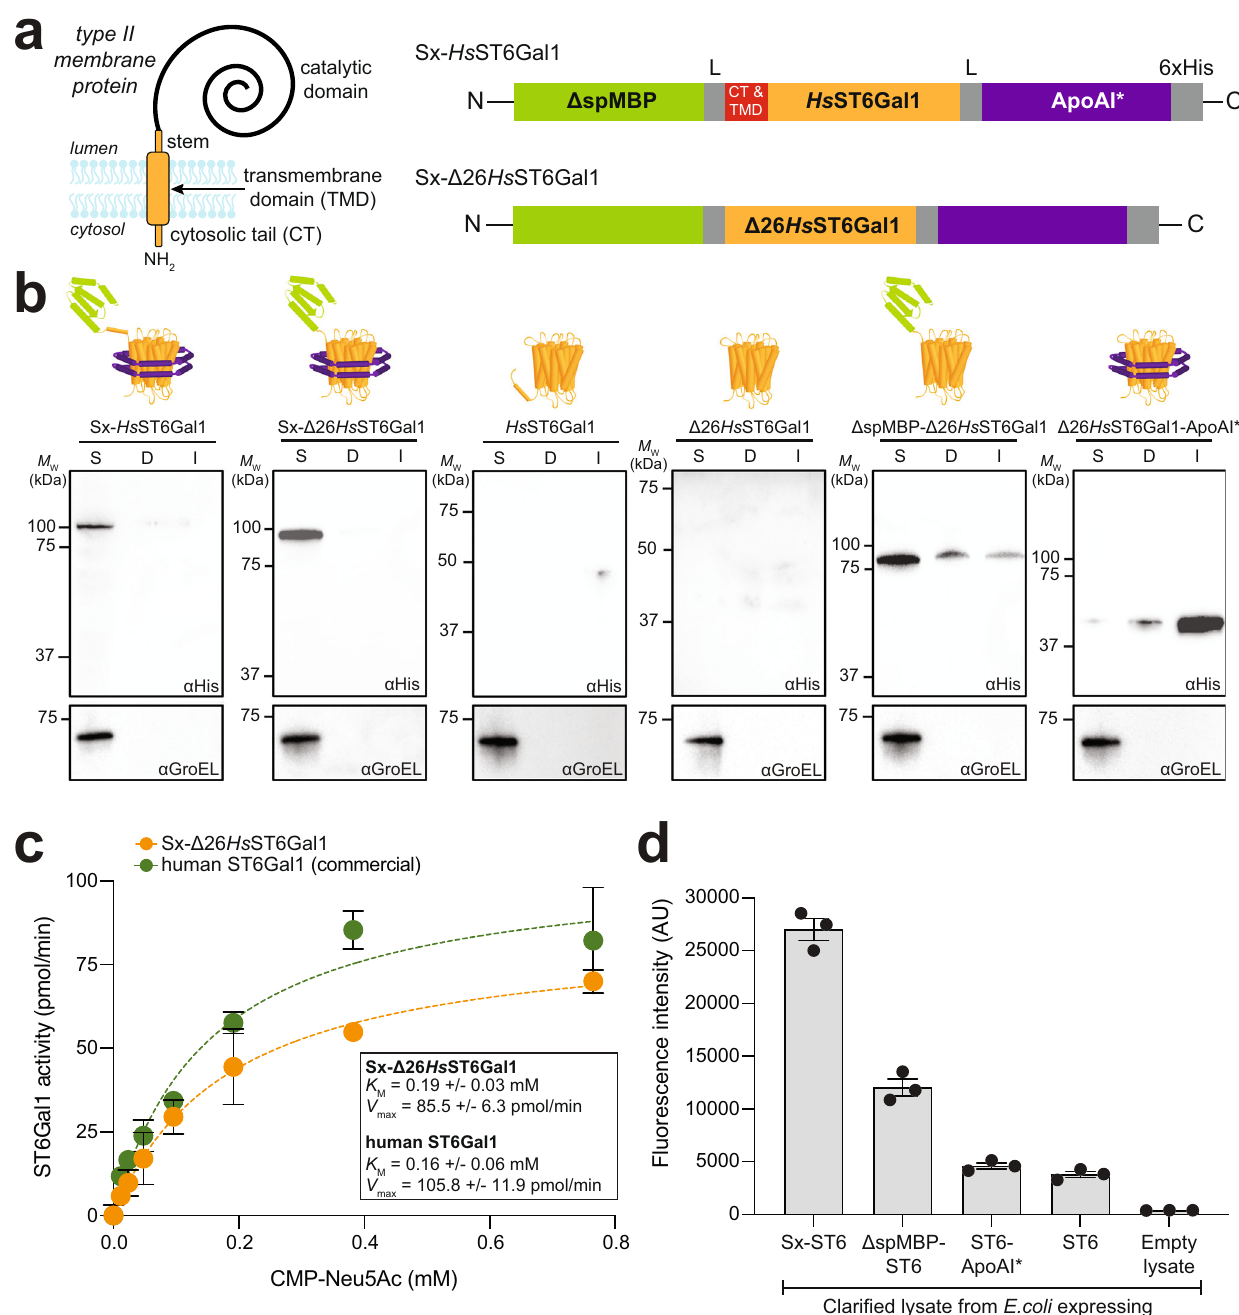
Fig. 1 | SIMPLEx-mediated expression of biologically active Hs ST6Gal1. a Membrane topology of type II transmembrane proteins and molecular archi- tecture of SIMPLEx constructs used in this study. Each construct consisted of N-terminal Δ spMBP and C-terminal ApoAI* that fl anked Hs ST6Gal1. Intervening fl exible linker (L) connects Δ spMBP and ApoAI* to the GT domains while the 6xHis tag was placed at the C-terminus to facilitate detection and puri fi cation. Hs ST6Gal1 domain variants studied here were wild-type (wt) Hs ST6Gal1 (top) and truncated Δ 26 Hs ST6Gal1 (bottom), in which the cytoplasmic tail (CT) and transmembrane domain (TMD) were removed. b Immunoblot analysis of the soluble (S), detergent- solubilized (D), and insoluble (I) fractions prepared from E. coli SHuf fl e T7 Express lysY cellscarryingplasmidpET28a(+)encodingeachoftheindicatedconstructs.An equivalent amountof totalproteinwas loaded ineach lane.Blots were probed with anti-polyhistidine antibody ( α His). Control blots were generated by probing with anti-GroEL antibody. Results are representative of three biological replicates. Molecular weight ( M w ) markers are shown at left. c Kinetic analysis of puri fi ed